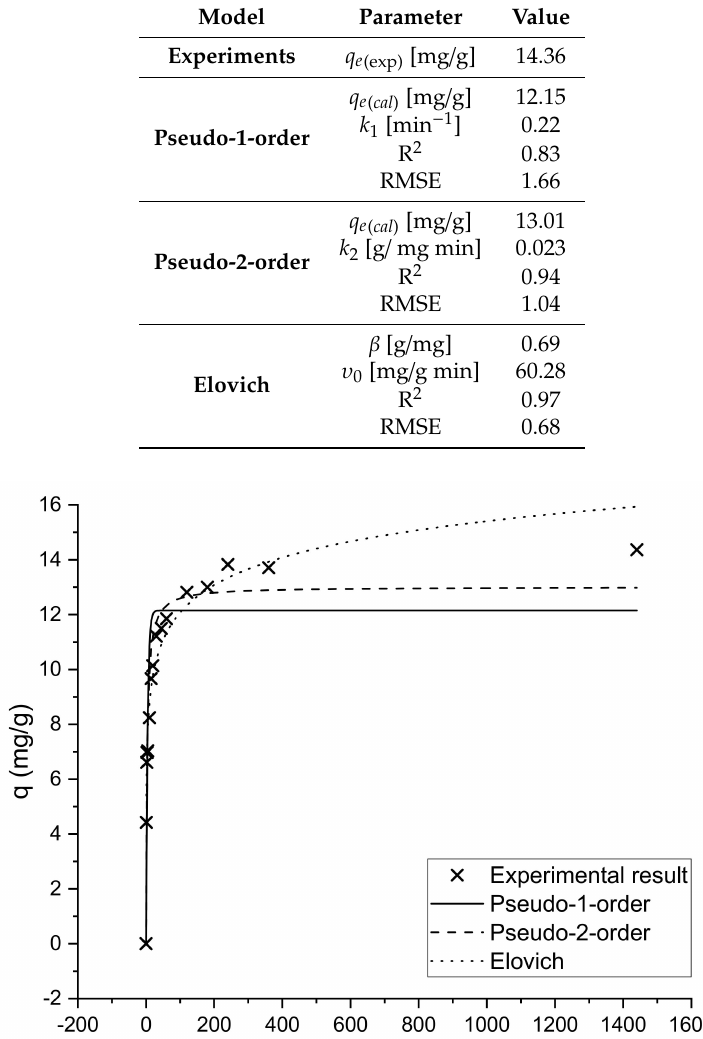
Table 4. Kinetic parameters of pseudo-first-order, pseudo-second-order, and Elovich models.